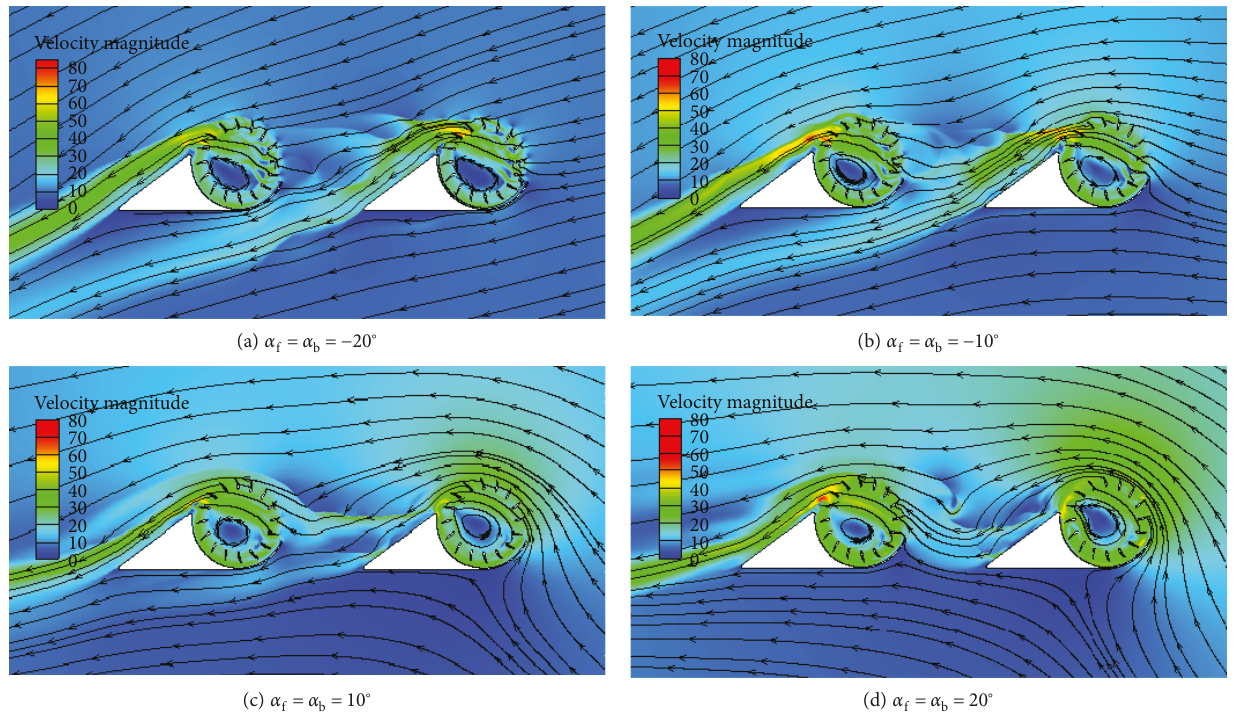
Figure 17: Velocity contours and streamlines of the front and rear fan wings when the front and rear wings have the same installation angle.